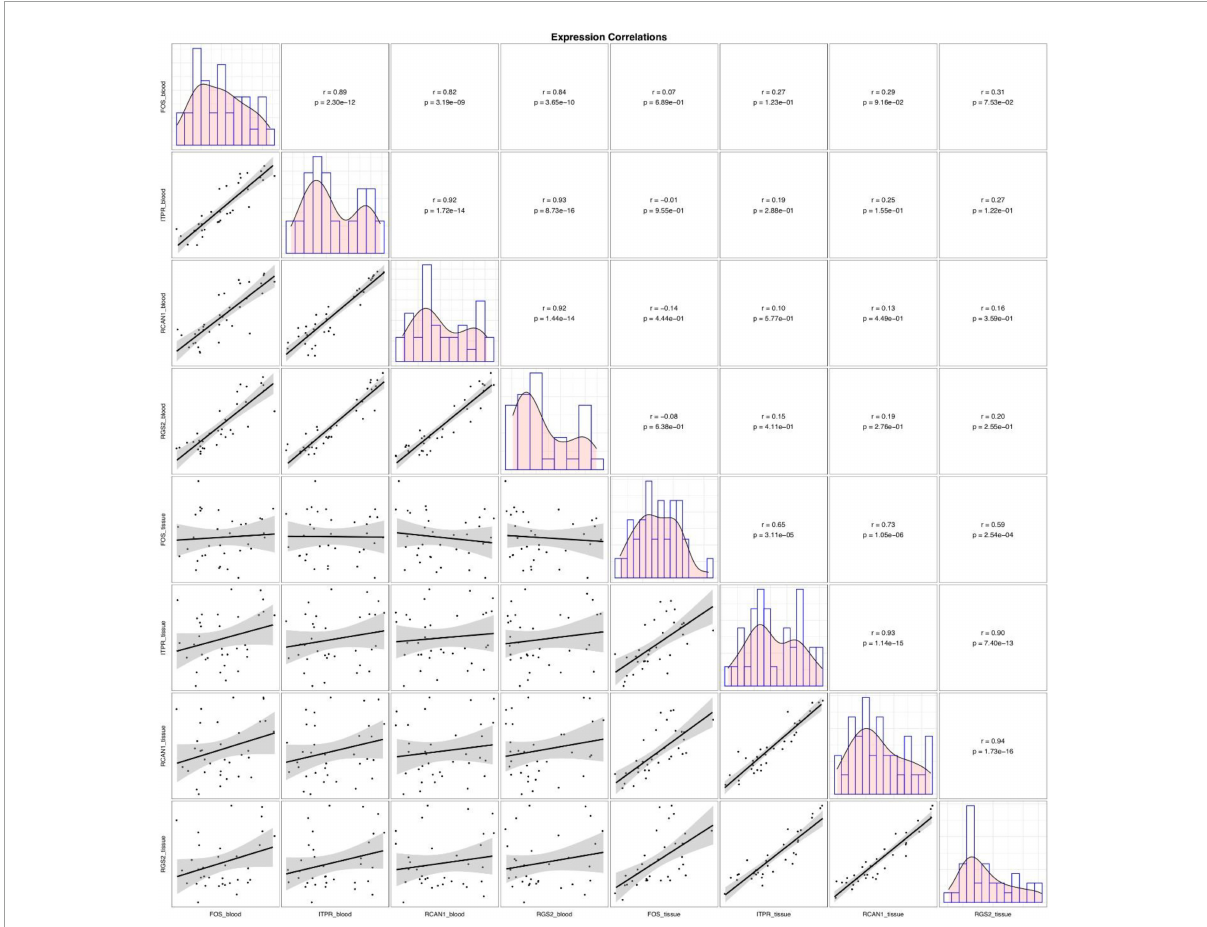
FIGURE3 Correlations between tissue/blood levels of FOS , ITPR , RCAN1 , and RGS2 genes. The distributions of parameters are indicated on the diagonals. The bivariate scatter plots with fitted lines are shown in the inferior parts. Correlation coefficients and P -values are shown in the upper part of the diagonal.